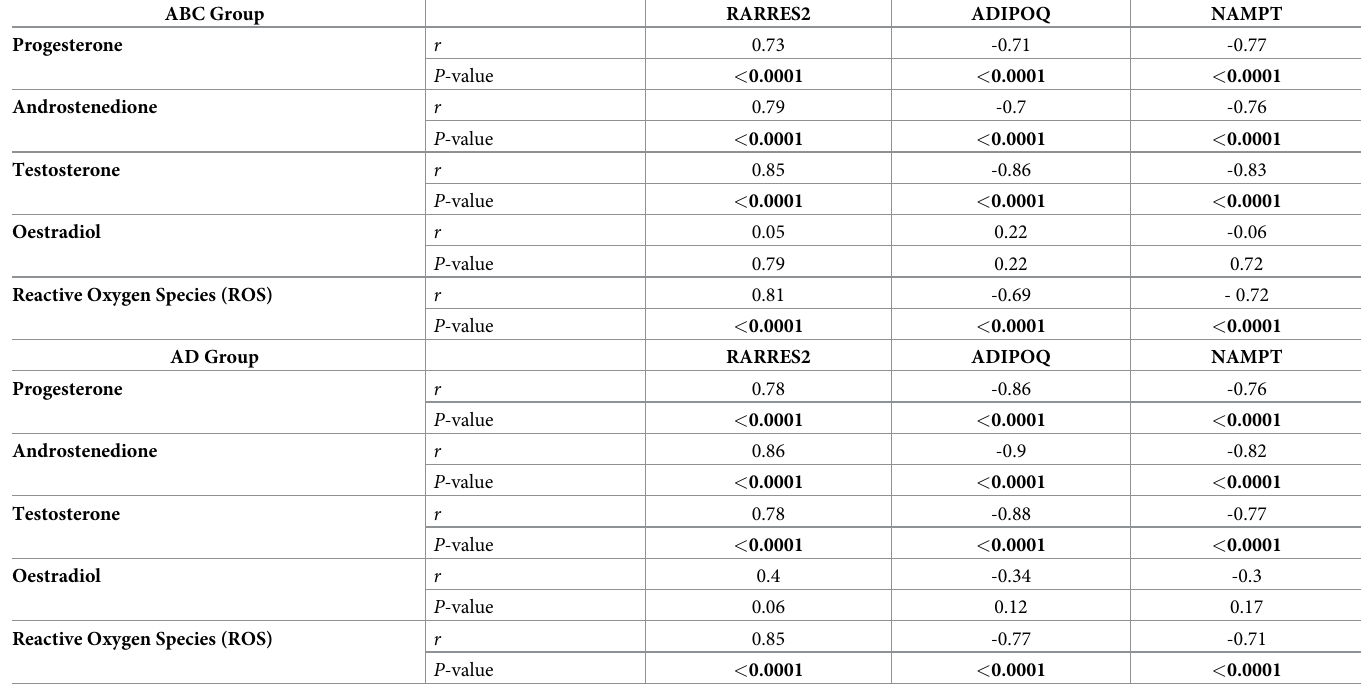
Table 4. Pearson correlation coefficient ( r ) calculated between plasma adipokines (RARRES2, ADIPOQ, NAMPT) concentration and steroids hormones (proges- terone, androstenedione, testosterone, oestradiol) and ROS concentration in egg yolk, for the groups A, B and C (experiment 1) and then, A and D (experiment 2).